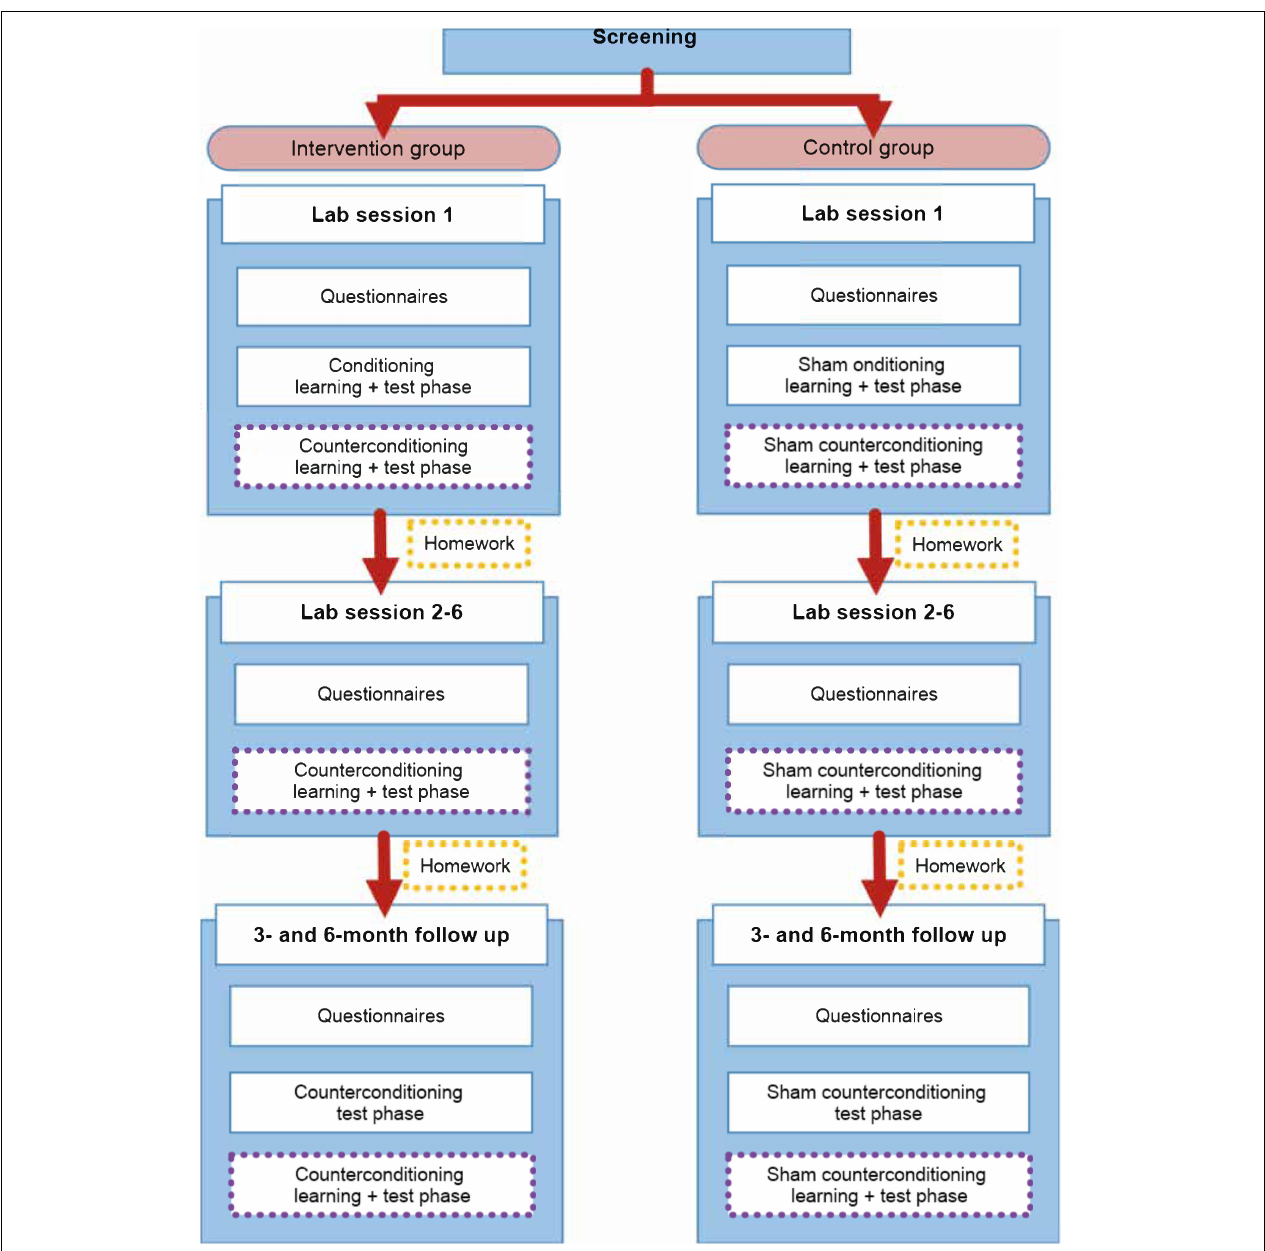
FIGURE 3 | Overview of the treatment protocol for use in patients with persistent physical symptoms, distinguished by group. The (sham) intervention parts of the procedure are emphasized by using purple dotted